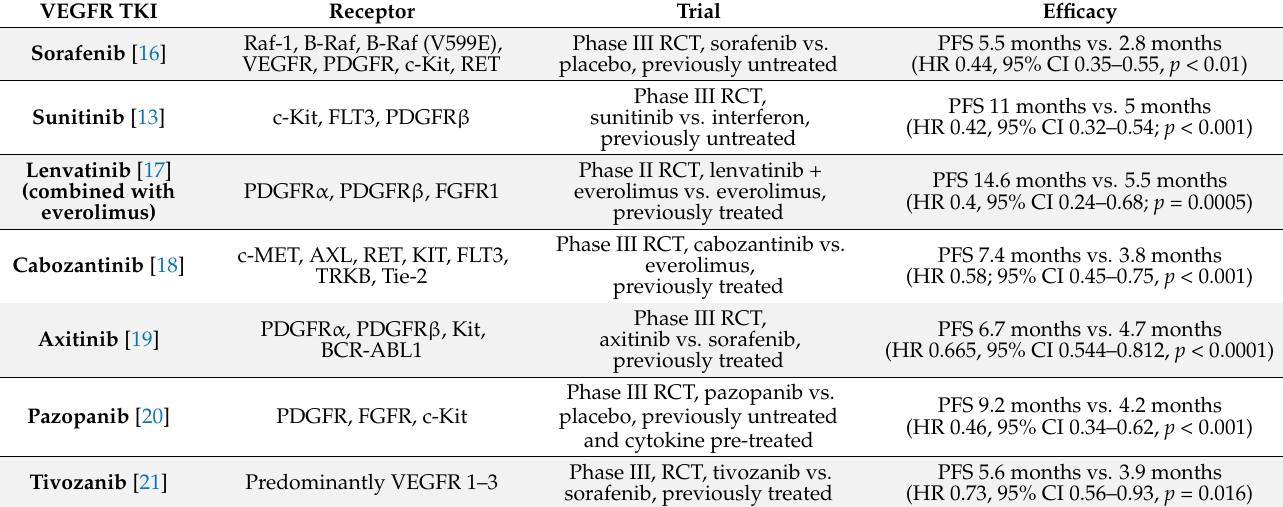
Table 1. FDA approved agents for advanced RCC targeting VEGF